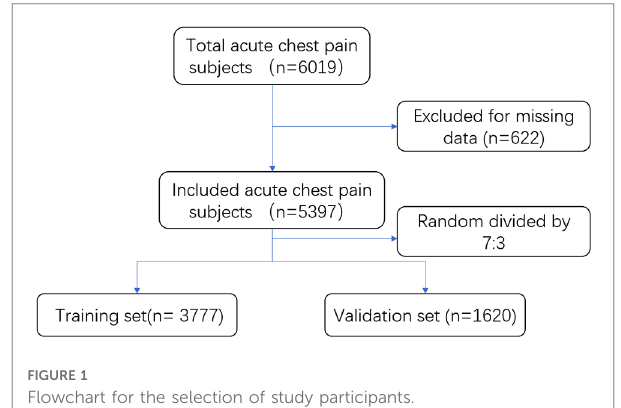
FIGURE 1 Flowchart for the selection of study